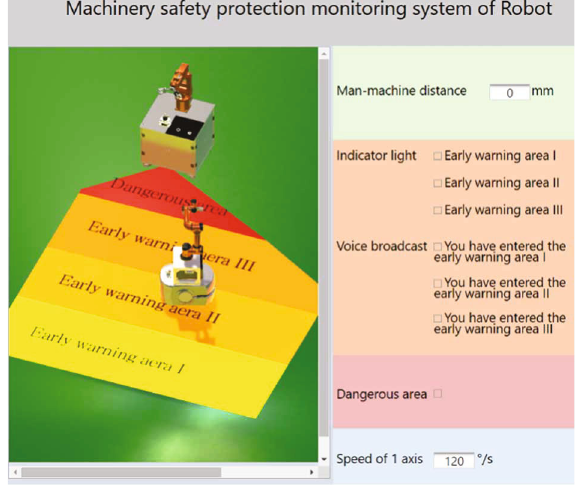
Figure 12: Monitoring system status when AGV invades early warning